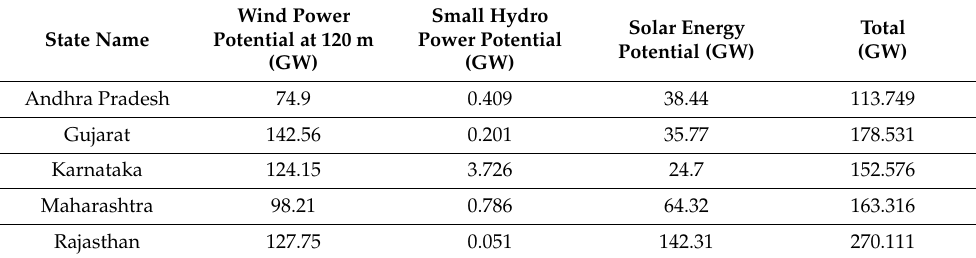
Table 1. Potential of renewable energy in high potential states [27,28].